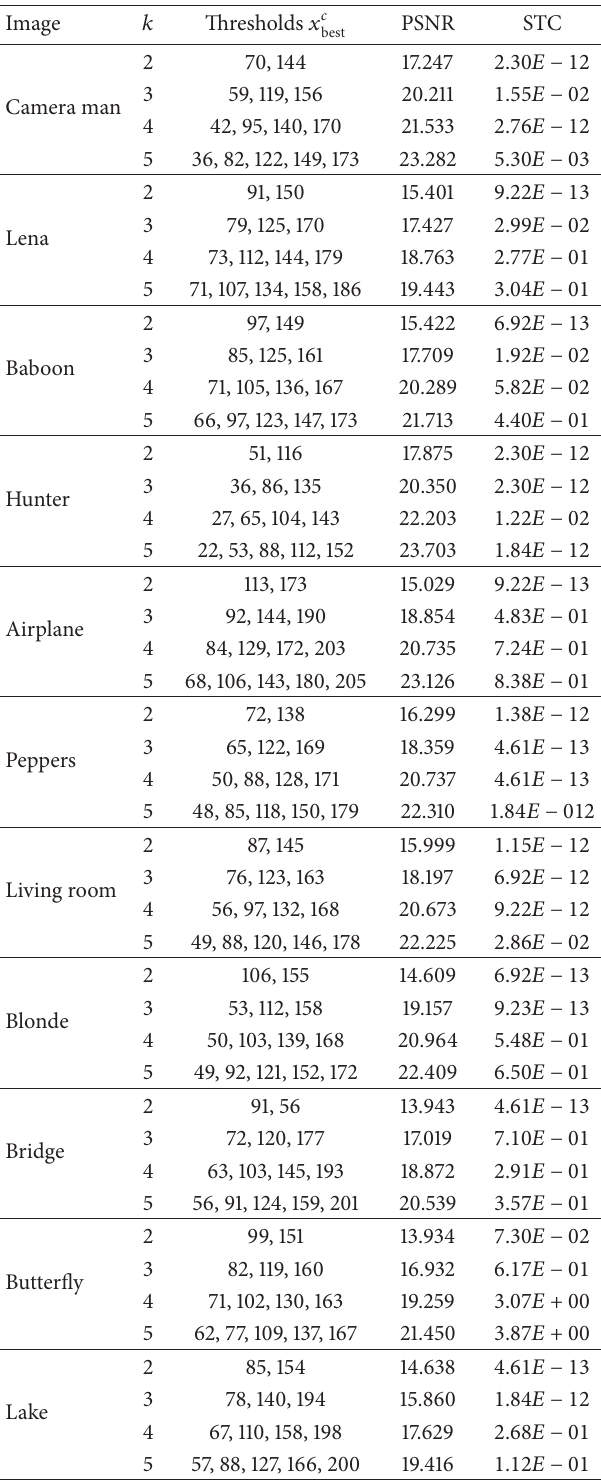
co are the total number of rows and columns of the image,